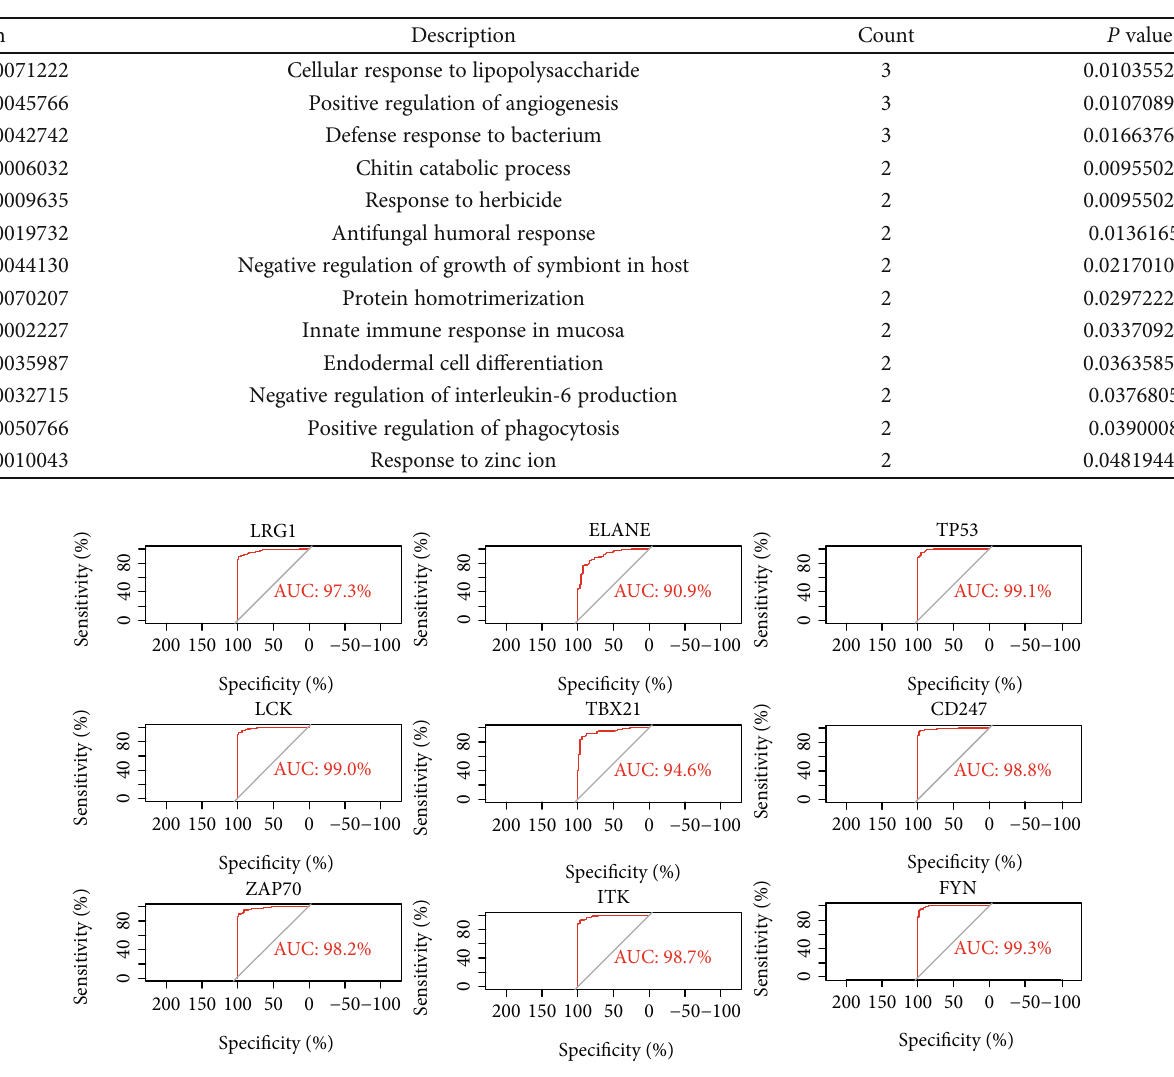
Figure 5: ROC curve analyses of 9 selected